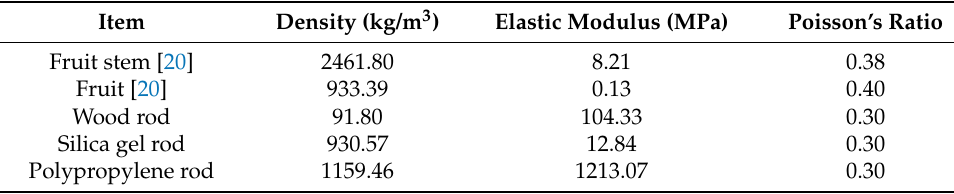
Table 4. The mechanical properties of the fruit stem, fruit, and